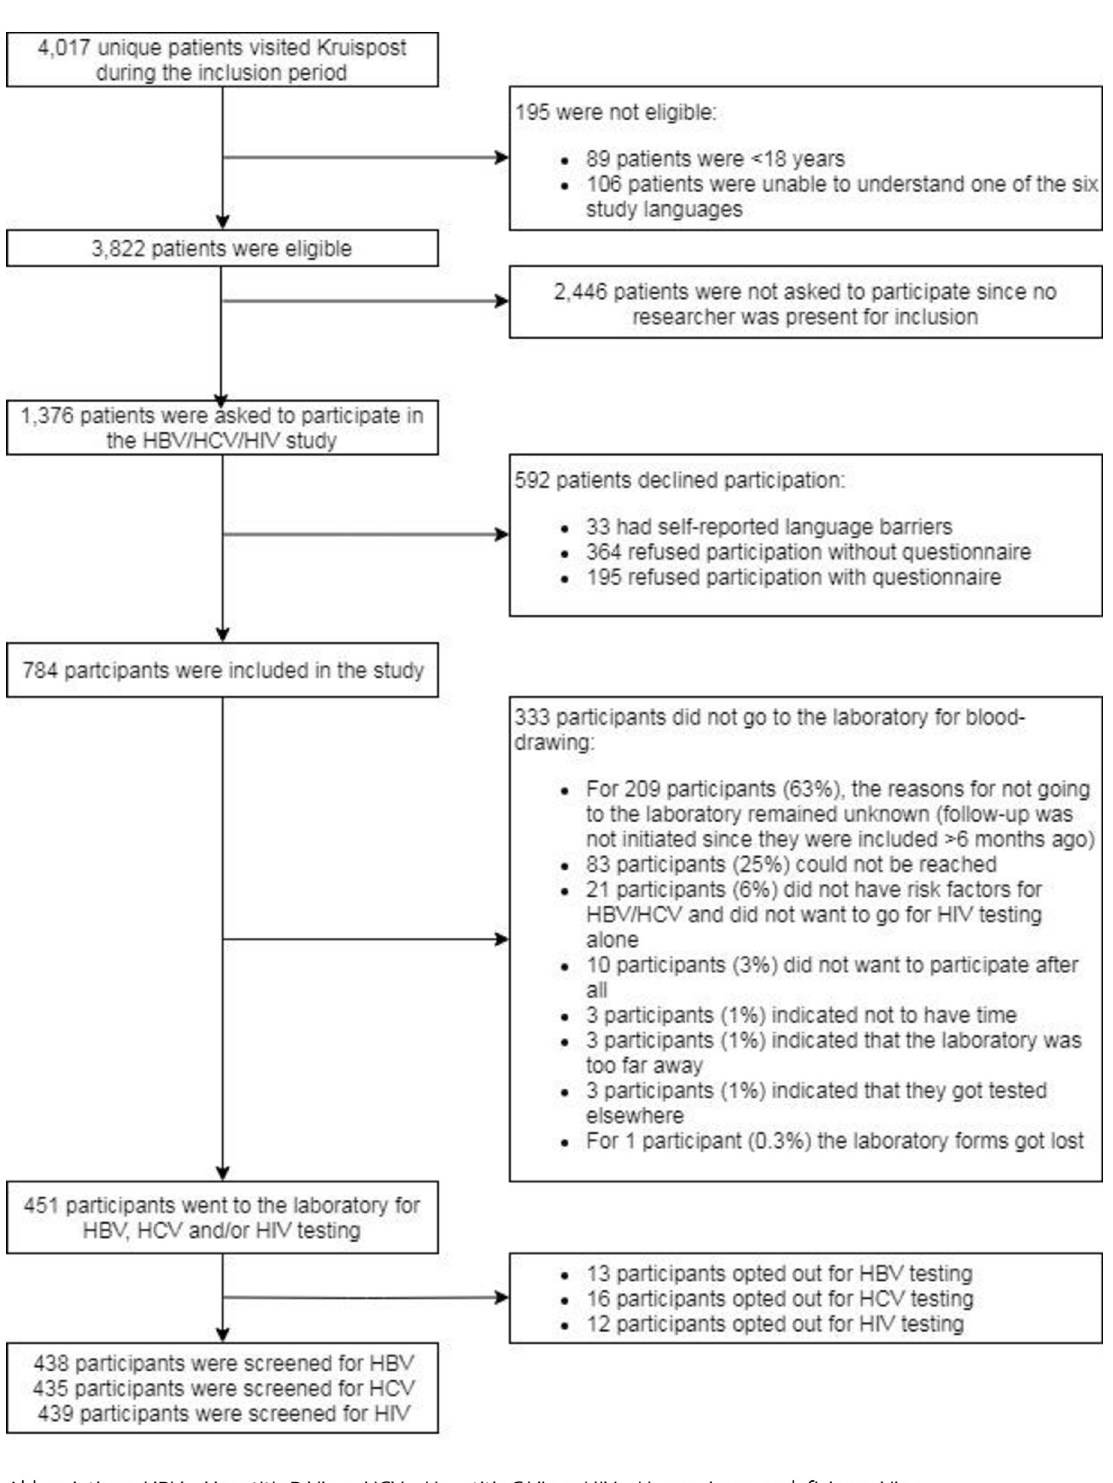
Fig 1. Flowchart depicting the recruitment strategy of HBV, HCV and HIV screening offered to undocumented migrants and uninsured legal residents attending Kruispost in Amsterdam, the Netherlands (N = 3,822).